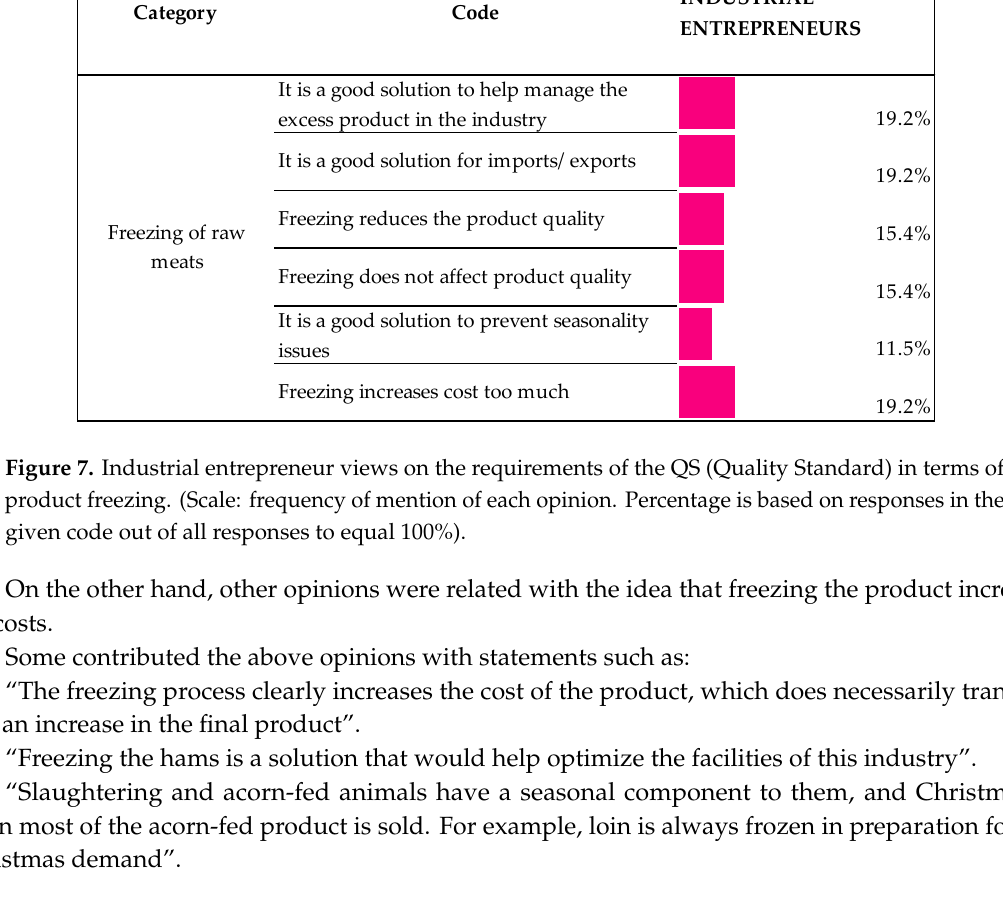
Figure 8. Industrial entrepreneurs’ views on the requirements of the QS (Quality Standard) in terms of the maturity times. (Scale: frequency of mention of each opinion. Percentage is based on responses in the given code out of all responses to equal 100%). As figure 8 shows, with over 85% in frequency of mention, industrial entrepreneurs stated that the maturity times for Iberian products—leg hams, shoulder hams and dry-cured loins—were adequate. “The acorn-fed product fully complies with it under the traditional system and in the case of the free-range fodder-fed product, it must comply too, as it is the case of a greased animal. If anyone were able to put it out earlier in the market by artificial means, they will do it, but… to what extent